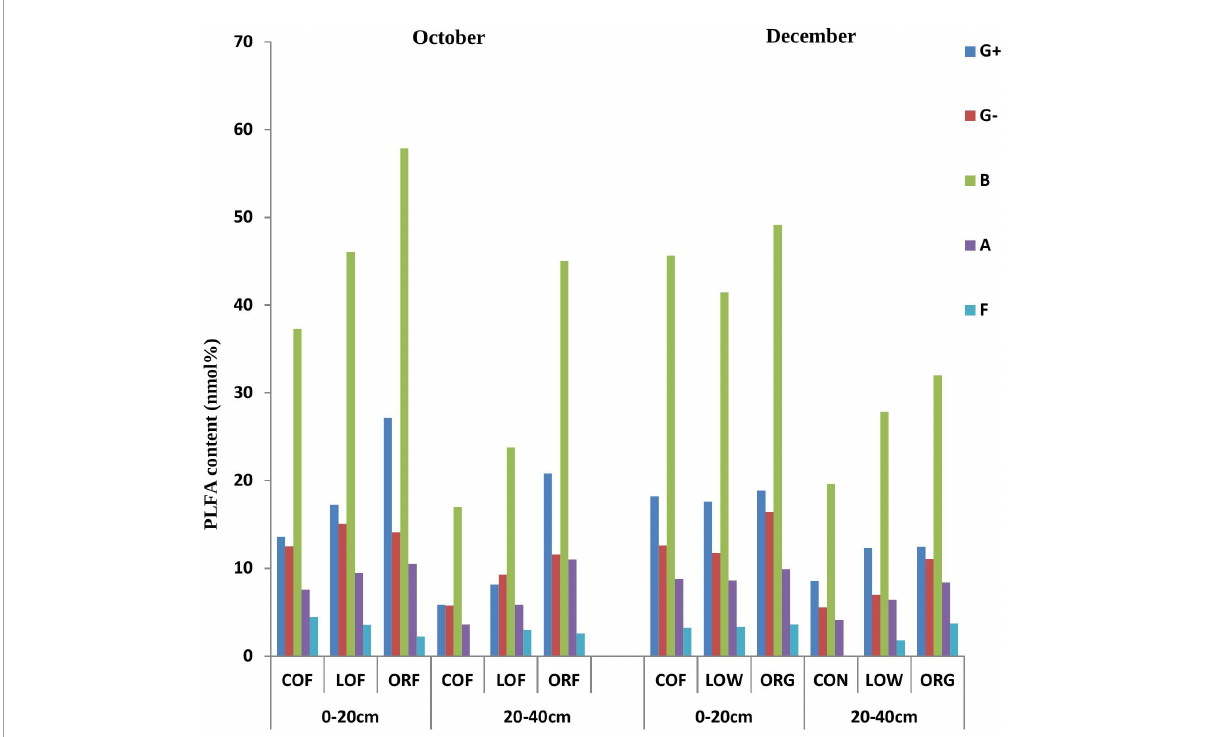
FIGURE1 Effect of different farming practices on PLFA content of various soil microbial types within different soil depths during different sampling months. Where, G +, Gram-positive bacteria; G– , Gram-negative bacteria; B, Bacteria; A, Actinomycetes; F, Fungi; October and December- Months of soil sampling; PLFA, Phospho-lipid fatty acids; COF, Conventional farming; LOF, Low input farming; ORF, Organic farming; 0–20 and 20–40 (cm)—Soil depth from where soil samples were